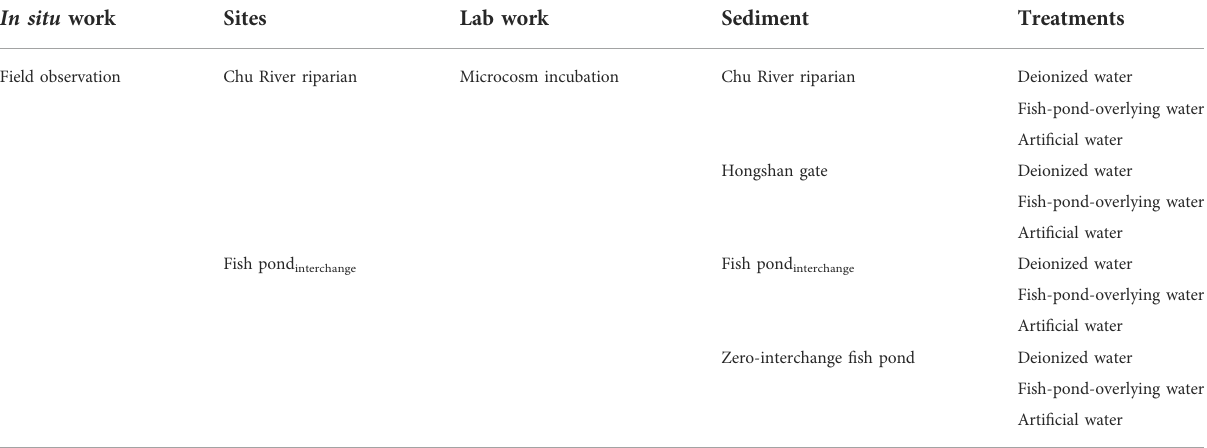
TABLE 1 Sample sites selection for fi eld observation and microcosm incubation. In situ